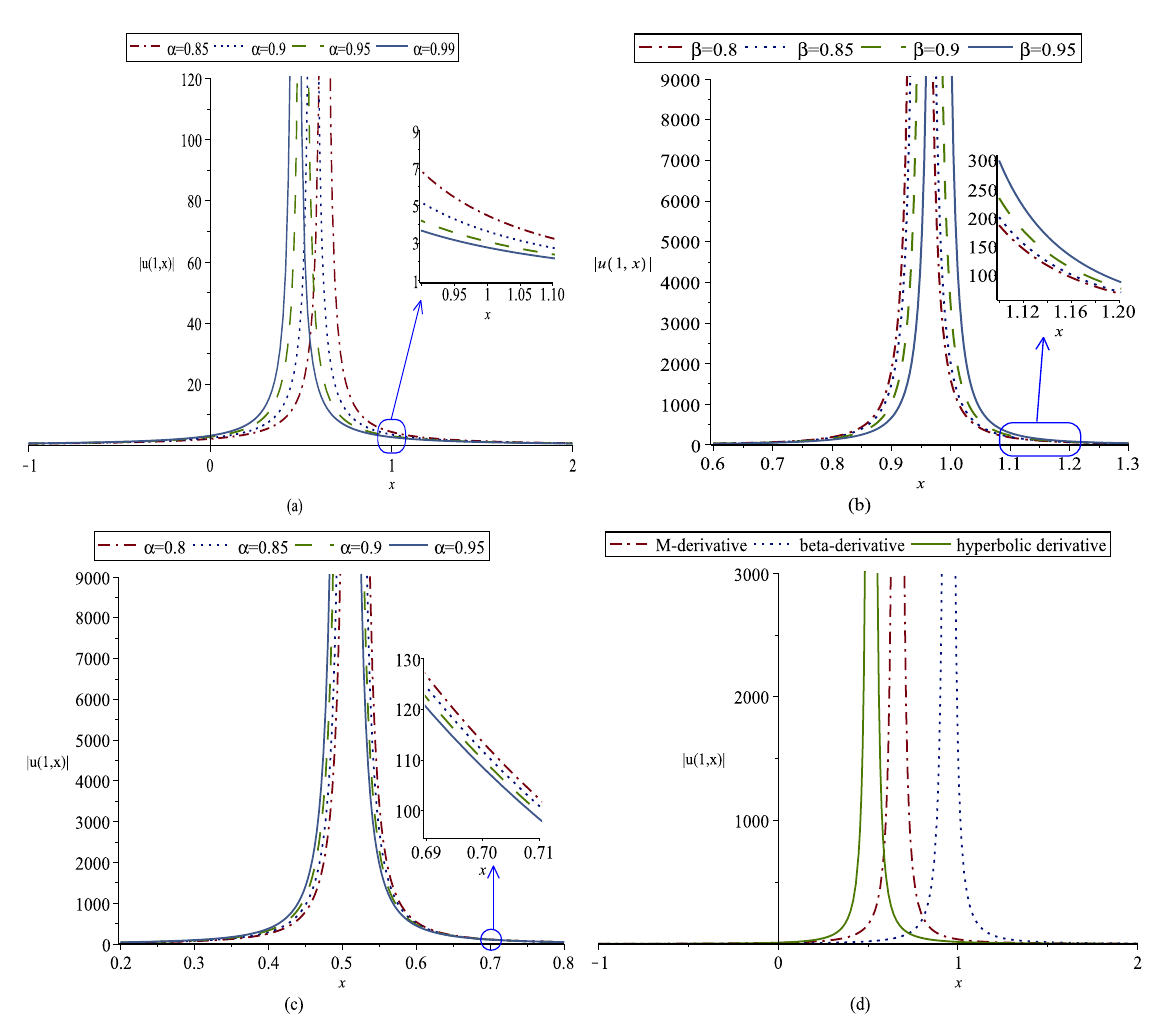
Figure 10. Exact solutions with k 1 = α 1 = a = c = 2, λ 3 = t = 1, m = 3, and ( a ) n = 1.5, β = 0.9, and various α w.r.t. M-derivative (34), ( b ) n = 2, and various β w.r.t. beta-derivative (35) ( c ) n = 2, and various α w.r.t. hyperbolic-derivative (36) ( d ) n = 2, α = β = 0.8, and various derivatives